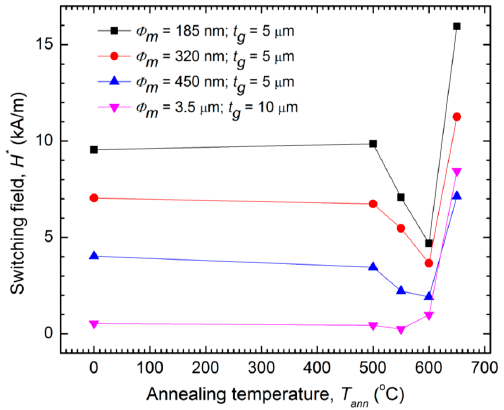
Figure 9. Dependence of the switching field on the annealing temperature for three ultrathin samples ( Φ m < 1 μ m) and one microwire sample ( Φ m ≥ 1 μ m).